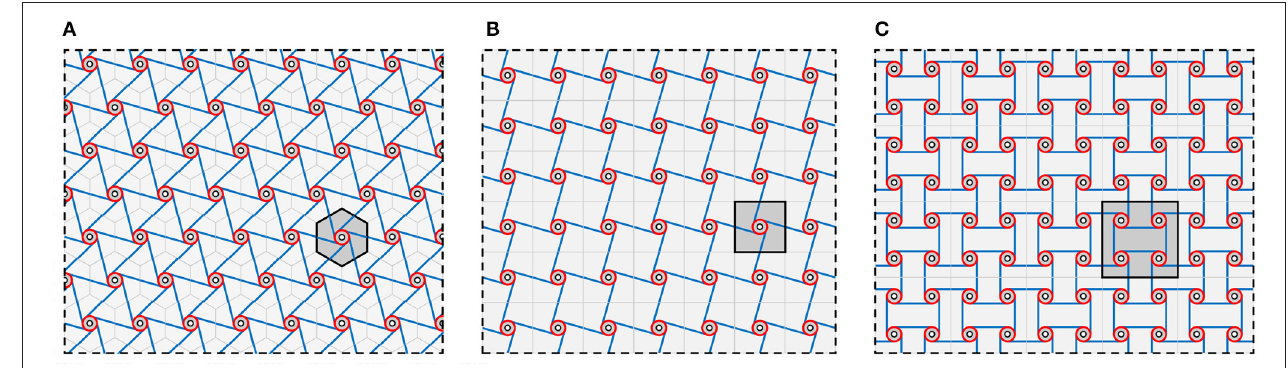
FIGURE 2 | Periodic microstructures and beam lattice models for different cell topologies: (A) hexachiral, (B) tetrachiral, (C) anti-tetrachiral.